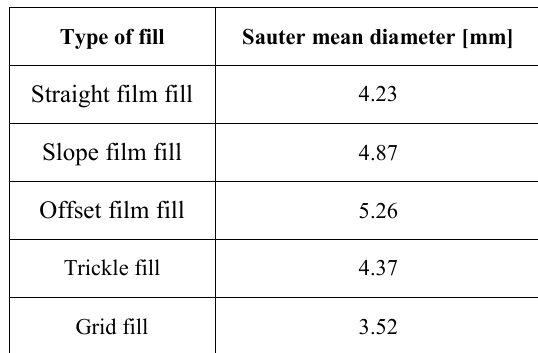
Table 1. Sauter mean diameter of each